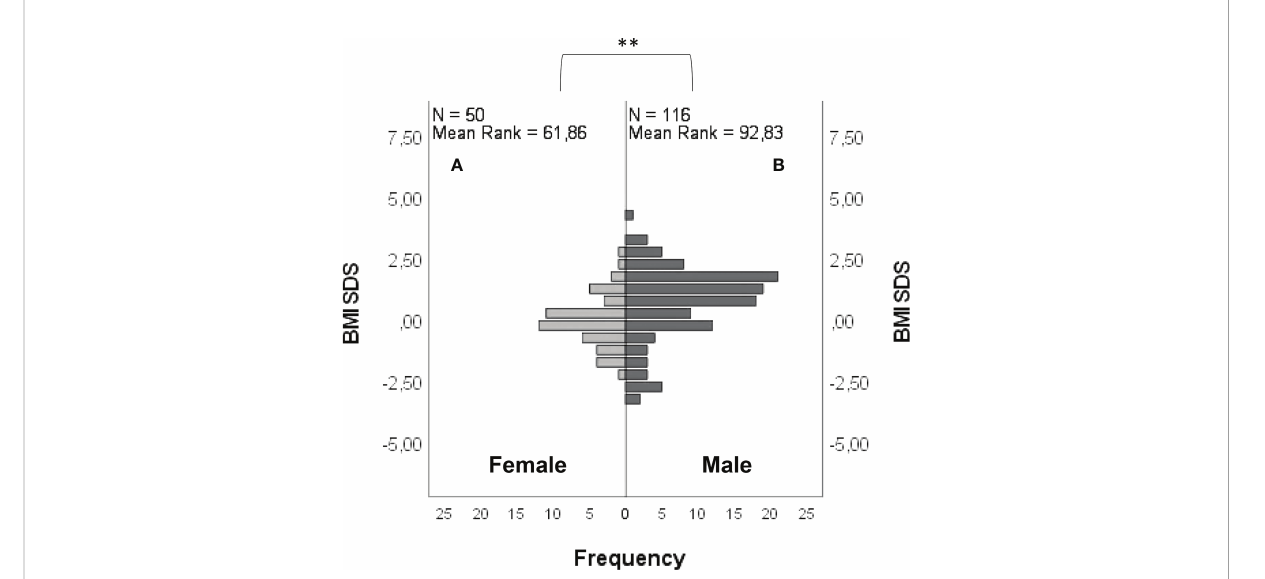
FIGURE 6 Frequency distribution of BMI SDS in female (A) and male (B) patients. Comparison between male and female cohorts using t -test: ** P =